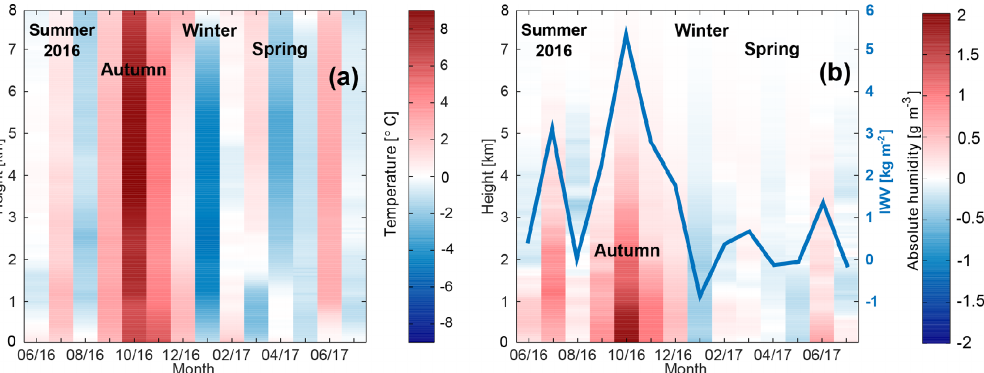
Figure 6. Anomalies of monthly mean atmospheric temperature (a) and absolute humidity (b) from radiosonde observations at Ny-Ålesund from June 2016 to July 2017. Anomalies are calculated with respect to the monthly mean values of the previous 23 years (1993–2015). The blue line corresponds to the IWV anomaly for the same time period.